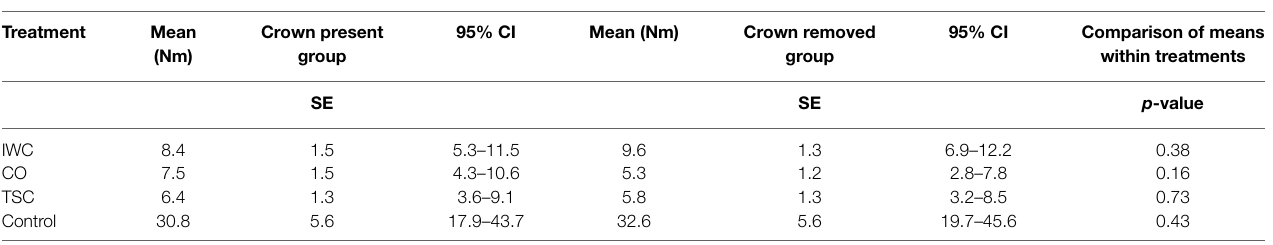
TABLE 1 | Ultimate strength of various forms of fixation and impact of crown removal are demonstrated . Ultimate strength of fixation techniques compared by crown status group comparisons within treatments